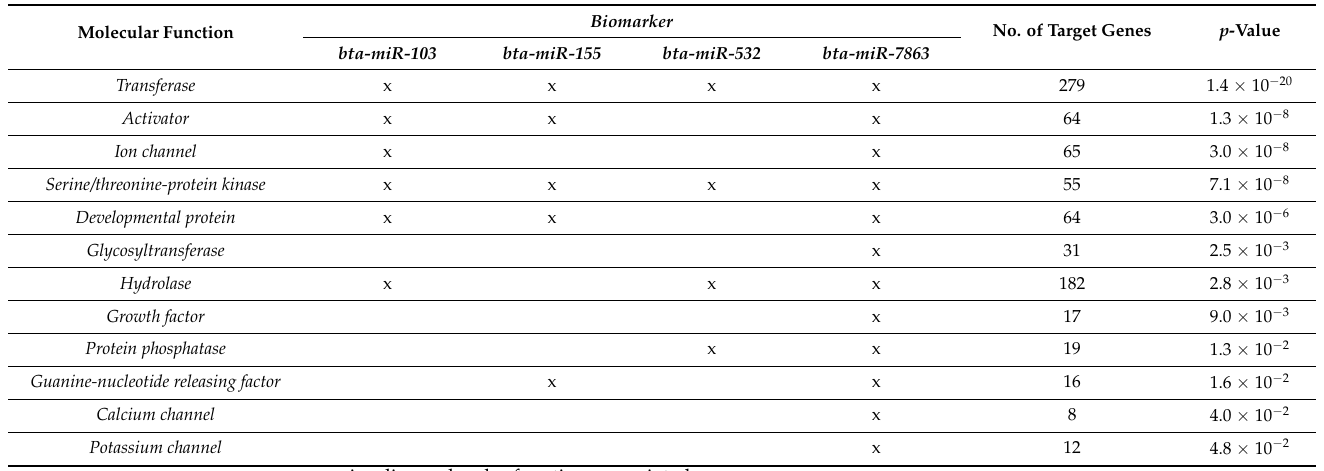
Table 3. Molecular functions that are associated with milk production and metabolism and that are predicted to be regulated by milk miRNAs with differential levels across production systems.